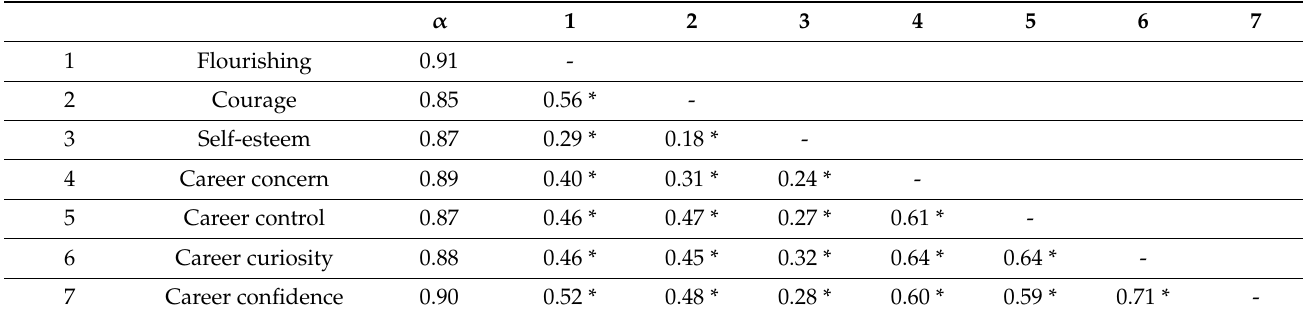
Table 2. Cronbach’s alpha and correlations.